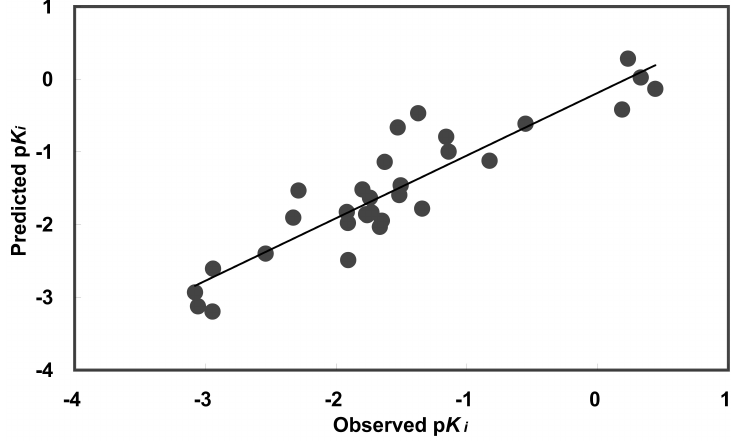
Figure 2. Predicted versus observed human A